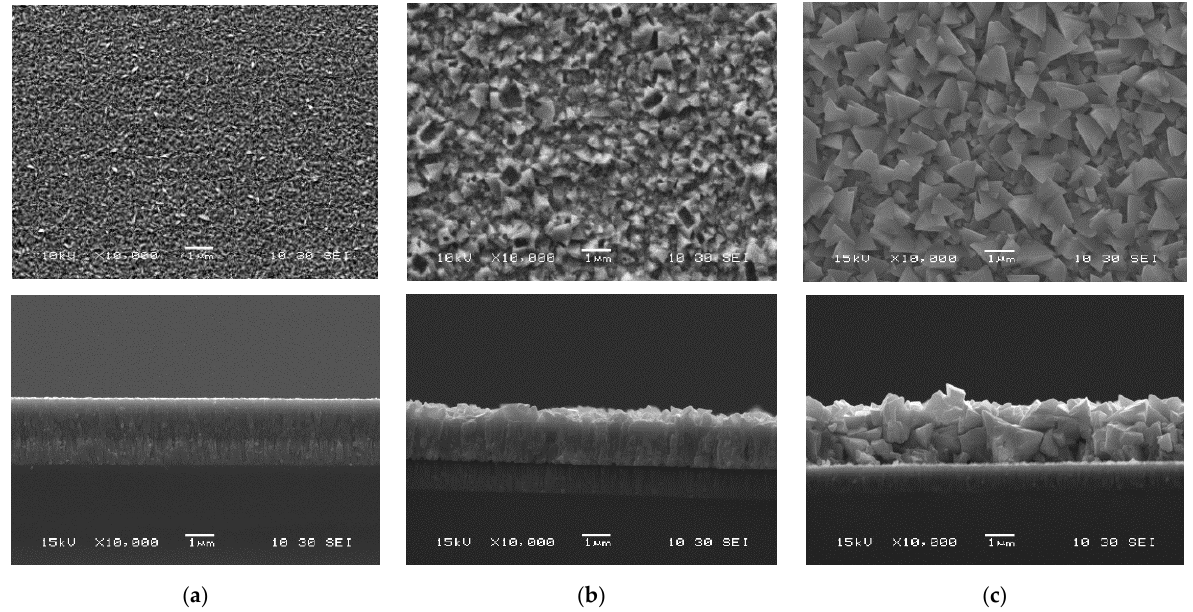
Figure 3. Scanning electron microscopy micrographs of CIGS films: as-deposited ( a ), recrystallized in Se ( b ), and recrystallized in InBr 3 ( c ) at 500 °C for 30 min.